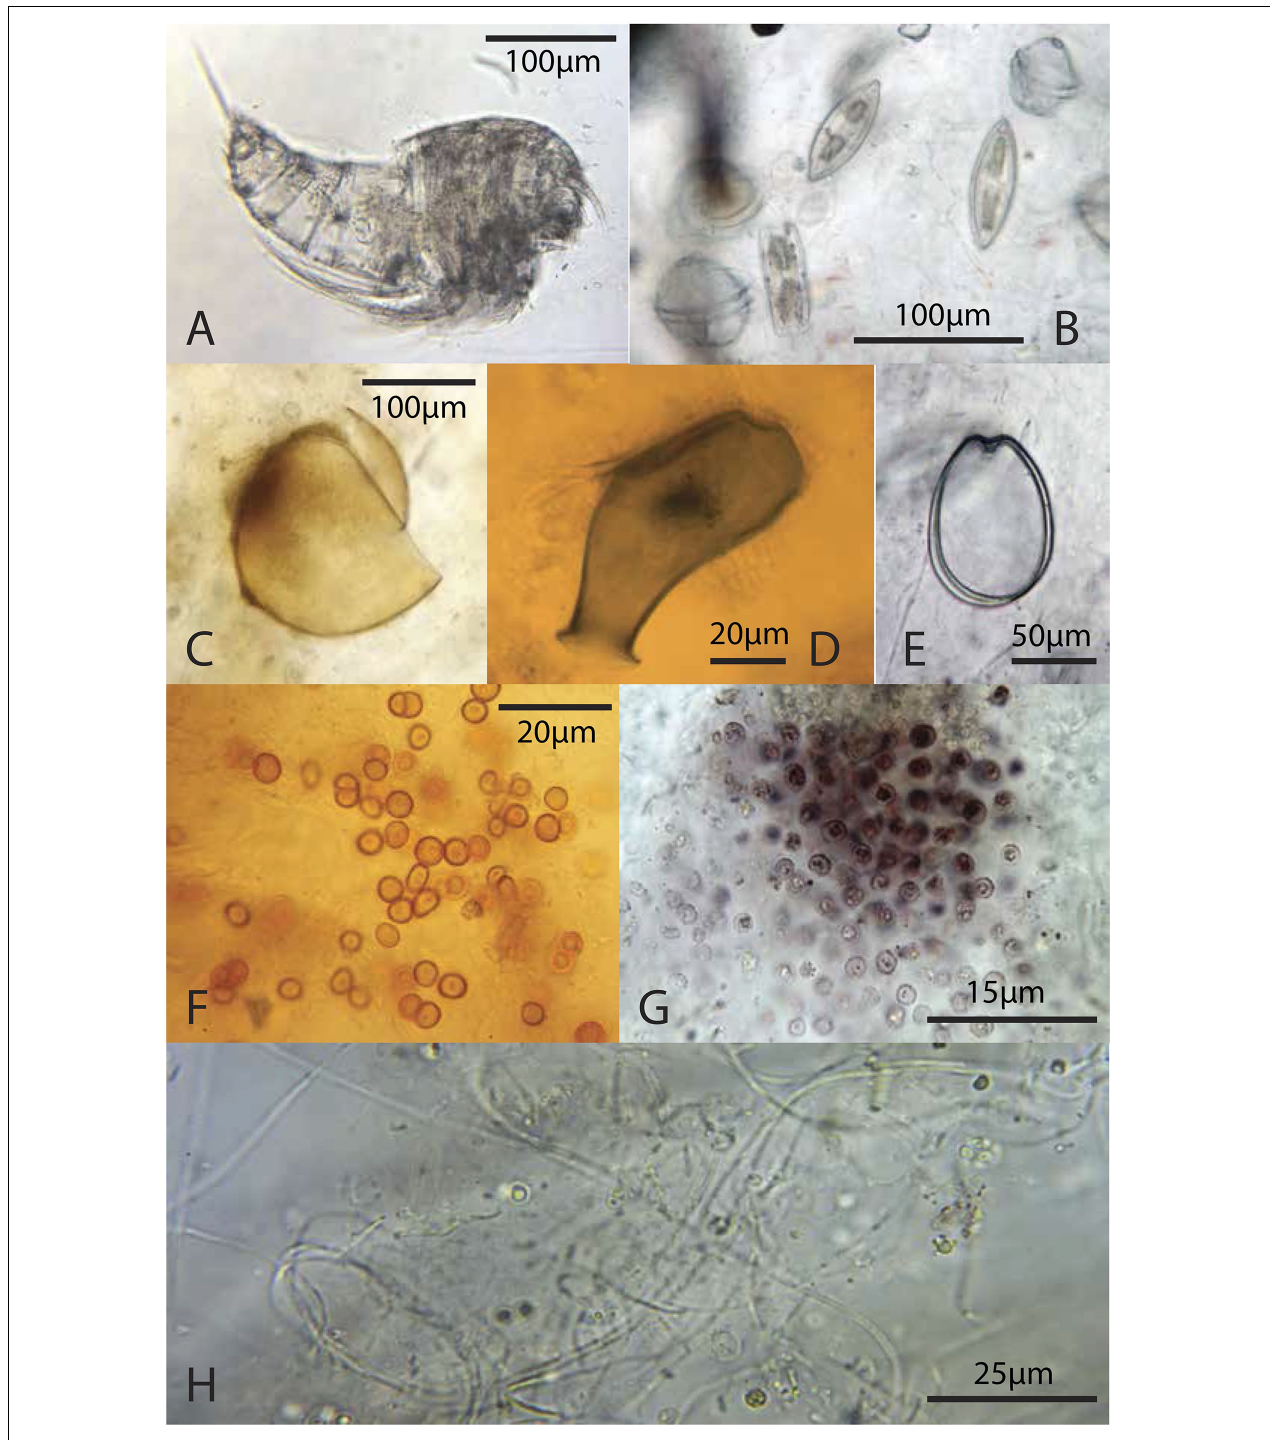
FIGURE 8 | Representative microbiota: (A) copepod from the green layer; (B) pennate diatoms and dinoflagellates from the green layer; (C) likely tintinnid from the green layer; (D) testate protist, possibly folliculinid ciliate, from a deep, pigment poor-layer, (E) athecate dinoflagellate from the green layer; (F) orange coccoid cells from the green layer; (G) pink coccoid cells from the brown layer; (H) thin filaments from the brown layer.